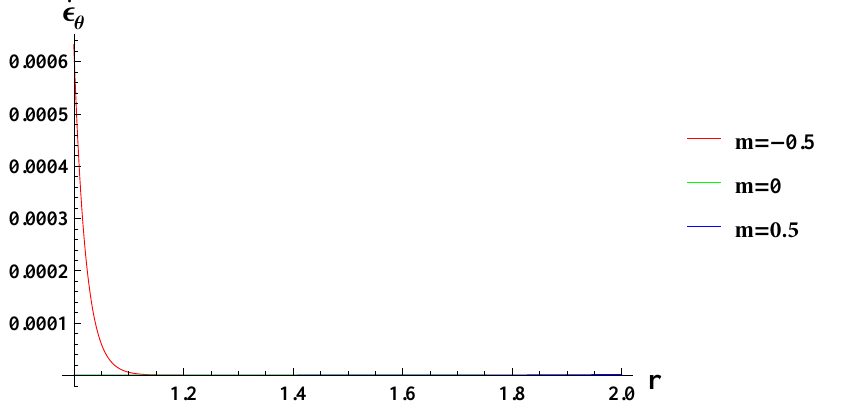
Figure 18. Radial strain rate along the radius r (in cm) of the cylinder, under the effect of rotation ( ω 2 = 50 rad/s), external pressure p o = 50 MPa and linear volume reinforcement.